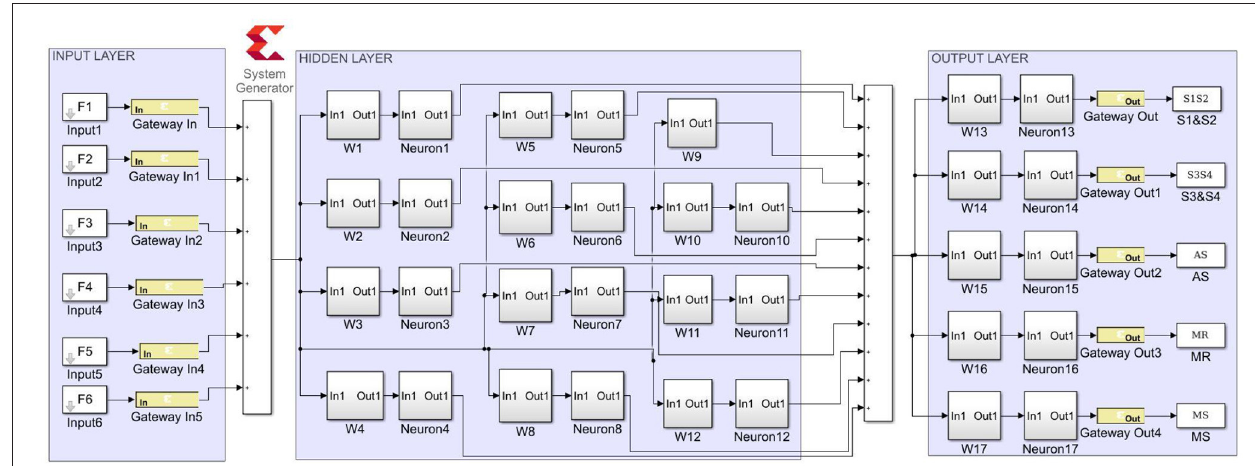
FIGURE 9 | System generator implementation of the ANN model.